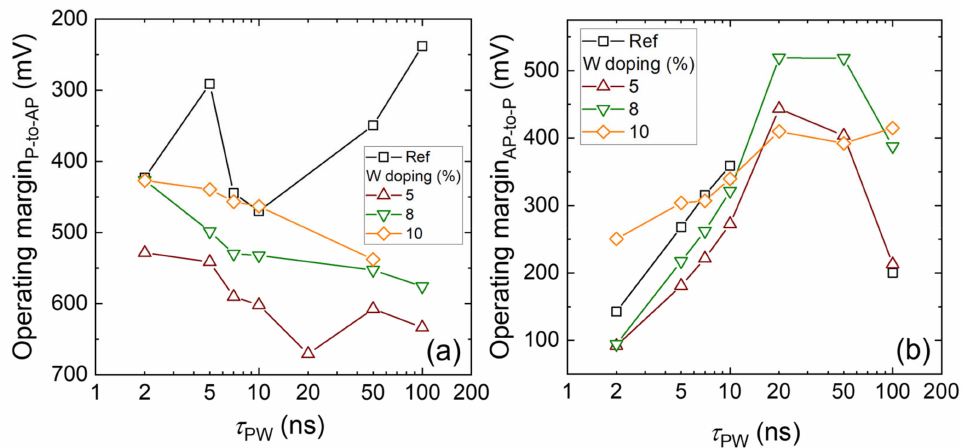
Figure 4. Absolute operating margins (V backhopping – V write ) estimated for the different FL options: ( a ) AP-to-P switching; ( b ) P-to-AP switching across the tested pulse duration range (2–100 ns). The margins are estimated from the median values of switching voltages and backhopping voltages. Negligible backhopping was observed for the 9% W-doped CoFeB FL, likely due to a stronger RL/MgO interface arising from the higher-than-expected RA product.